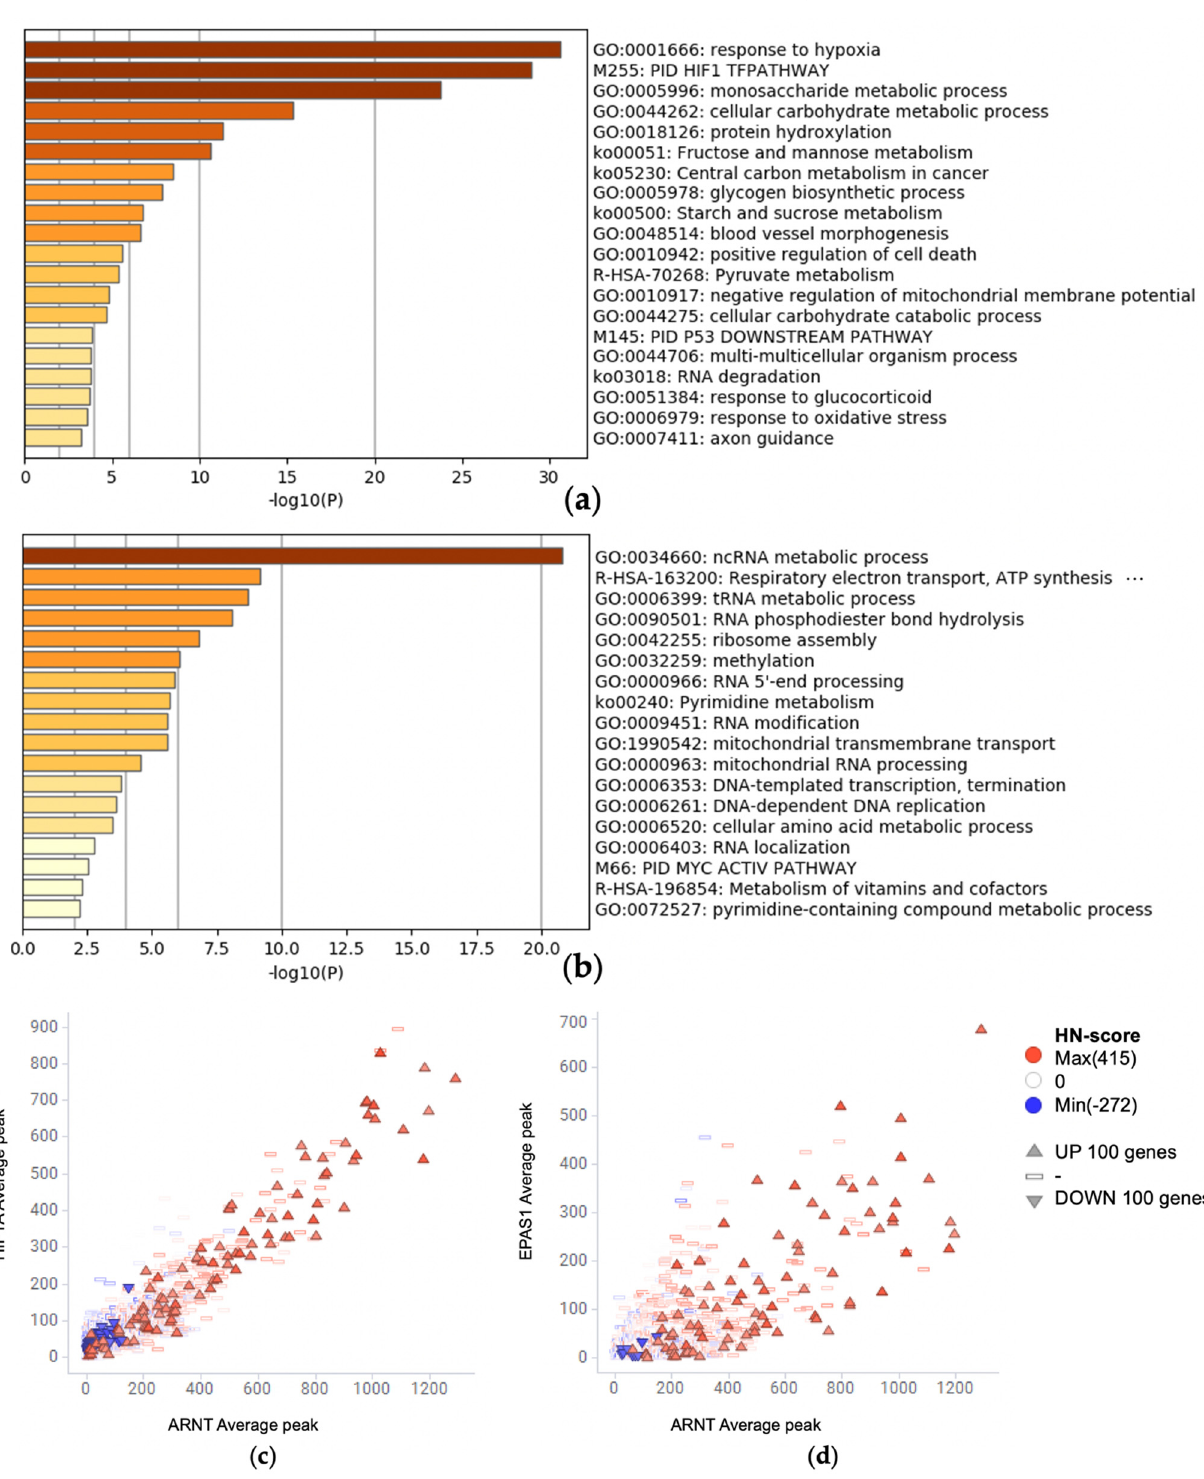
Figure 2. ( a , b ) Confirmation of known hypoxic stimulation-related genes. Enrichment analysis for ( a ) the UP 100 gene list and ( b ) the DOWN 100 gene list. ( c , d ) Scatter plot of ChIP-seq average peaks of hypoxic-related antigens, ( c ) HIF1A vs. ARNT and ( d ) EPAS1 vs. ARNT colored by HN-score. Table 1. The result of enrichment analysis in ChIP-Atlas. Enrichment analysis in ChIP-Atlas is a search tool for target genes and colocalizing factors of a given transcription regulator.